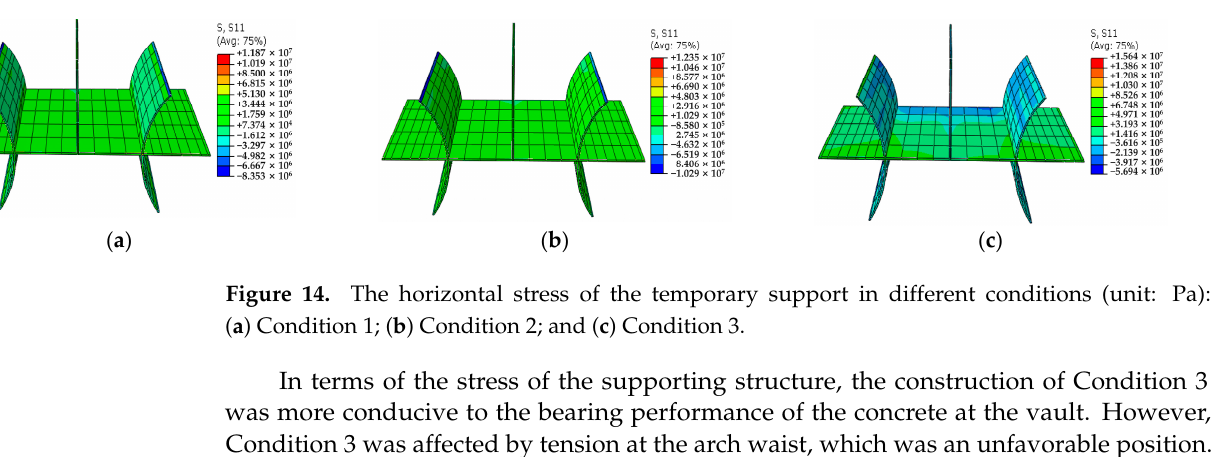
Figure 13. The horizontal stress of the primary support in different conditions (unit: Pa): ( a ) Condition 1; ( b ) Condition 2; and ( c ) Condition 3.